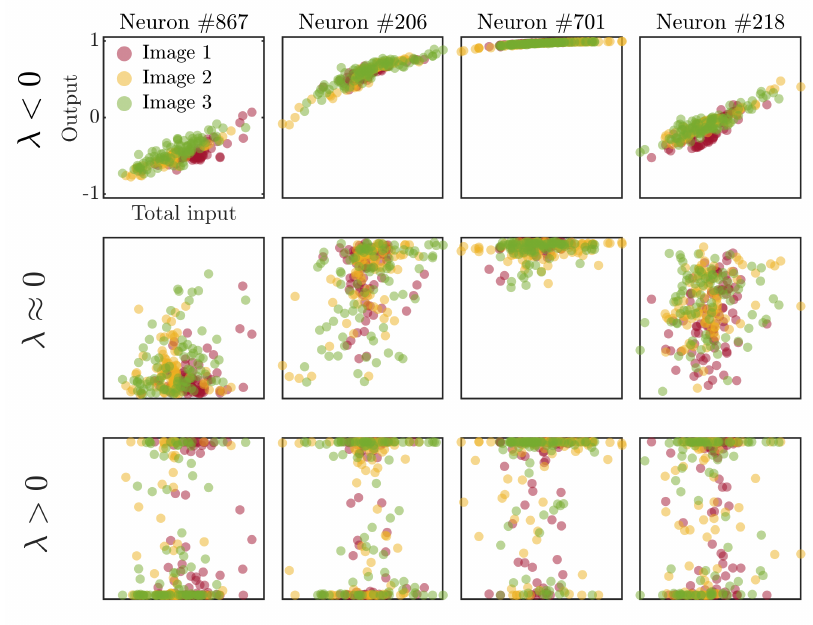
respectively. Each plot represents the activity of the corresponding neuron at each time step against the total input (sum of external input plus reverberating activity in Equation (1)) arriving to the neuron at the previous time. Since each image is first transformed into a multivariate time series of T = L 2 = 90 time steps—and we plot the activity along the first three images only—each panel in Figure A1 contains 270 points.